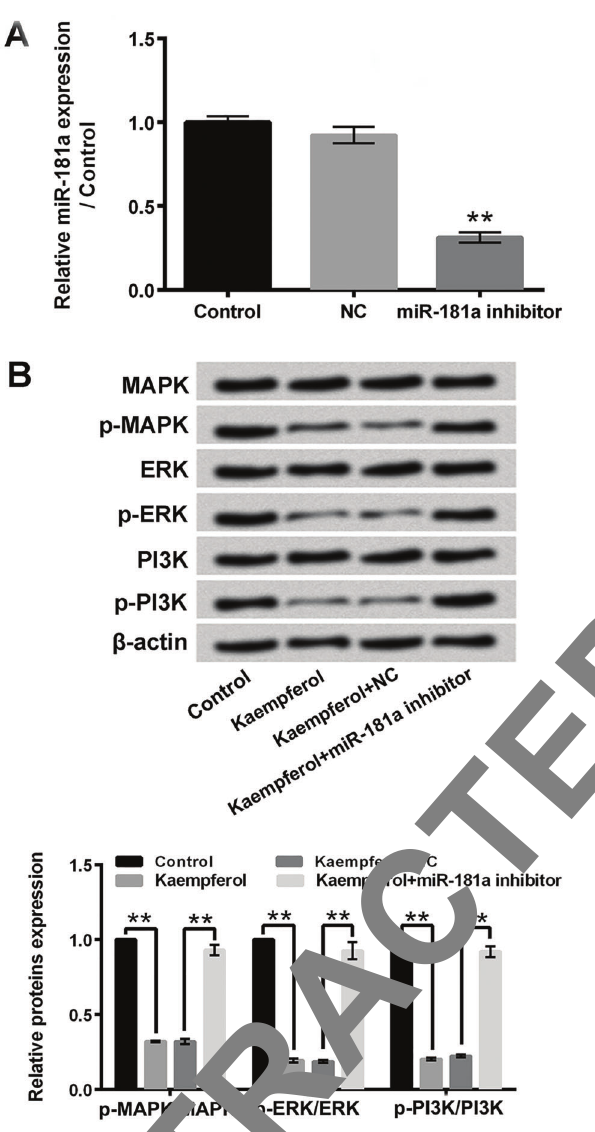
Figure 7. microRNA (miR)-181a participated in the kaemp- ferol-induced MAPK/ERK and PI3K pathways inactivation in SNU-216 cells. A , After miR-181a inhibitor transfection, the expression of miR-181a in SNU-216 cells was detected using quantitative reverse transcription PCR. B , Western blotting was performed to evaluate the expressions of MAPK, p-MAPK, ERK, p-ERK, PI3K, and p-PI3K in SNU-216 cells after 50 m M kaempferol treatment and/or miR-181a inhibitor transfection. NC: negative control; MAPK: mitogen-activated protein kinase; ERK: extracellular regulated protein kinases; PI3K: phospha- tidylinositol 3 kinase. Data are reported as means ± SD. **P o 0.01 (ANOVA). kaempferol-induced MAPK/ERK and PI3K pathways inactivation in gastric cancer SNU-216 cells.